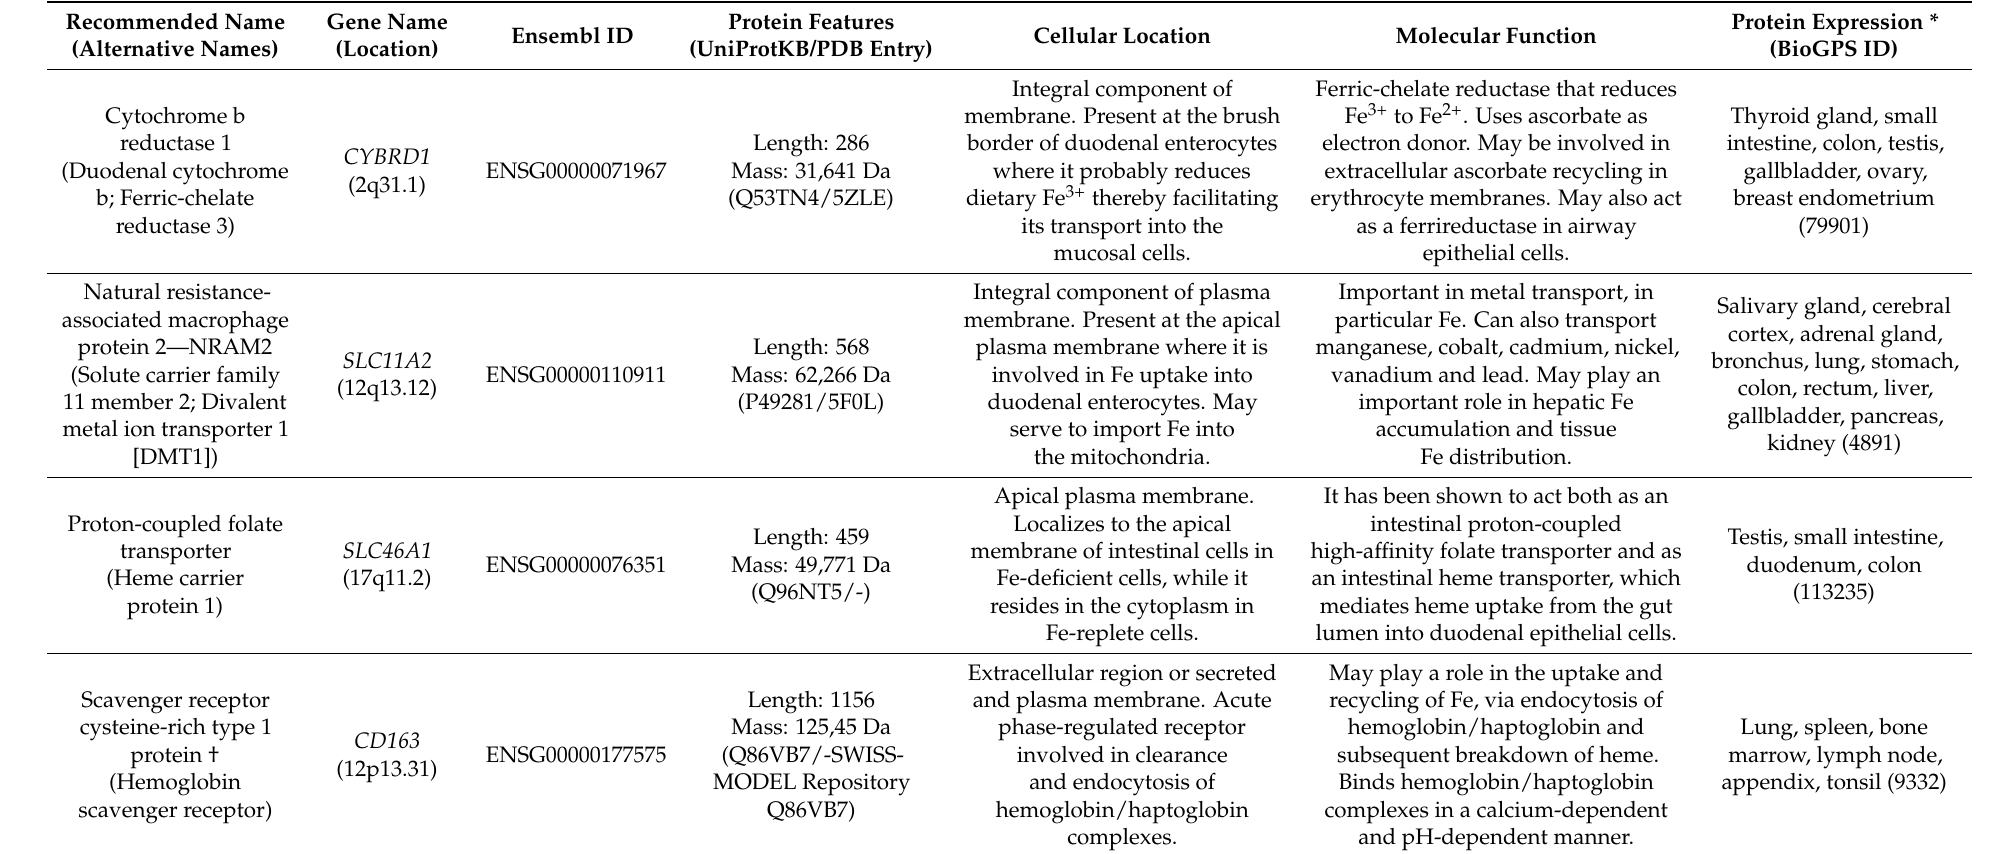
Table 1. Characteristics of prioritized proteins of iron